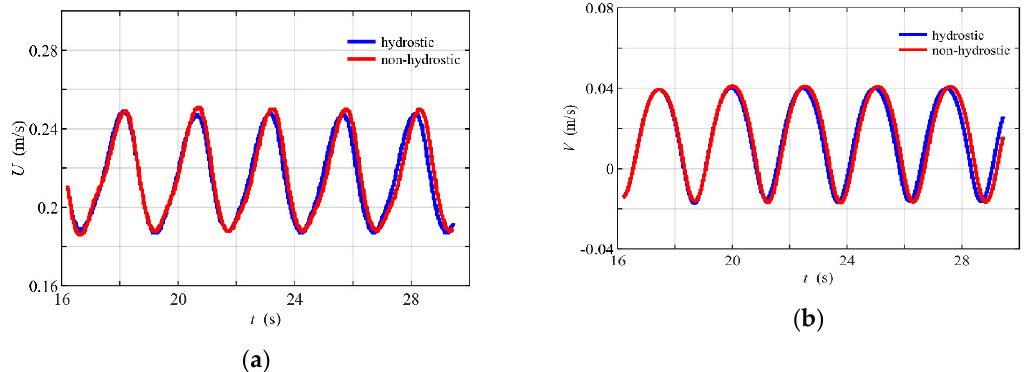
and 0.210 for hydrostatic and non-hydrostatic SWM, respectively. This value is close to 0.218 obtained √ by the formula St = 0.2698 − 1.0271/ Re given by [59].